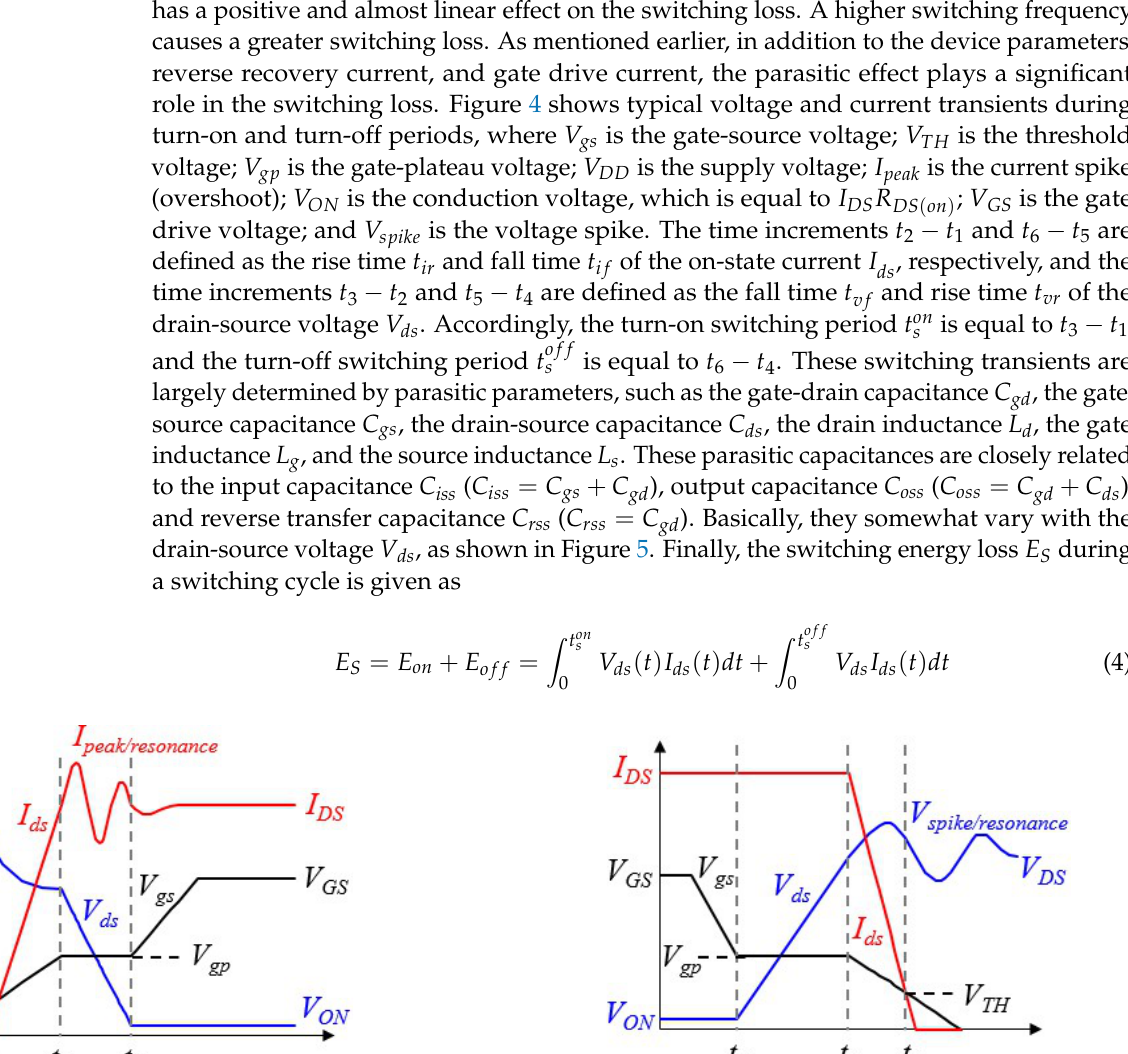
Figure 5. V ds -dependent input, output, and reverse transfer capacitances. 4. EM Electro-Thermal Analysis 4.1. EM Modeling Maxwell’s equations, consisting of a set of coupled partial differential equations, are generally used to depict macroscopic electromagnetism phenomena. The equations indi- cate that EM waves moving along a field depend on time, space, the electric field, and the magnetic field [32]: